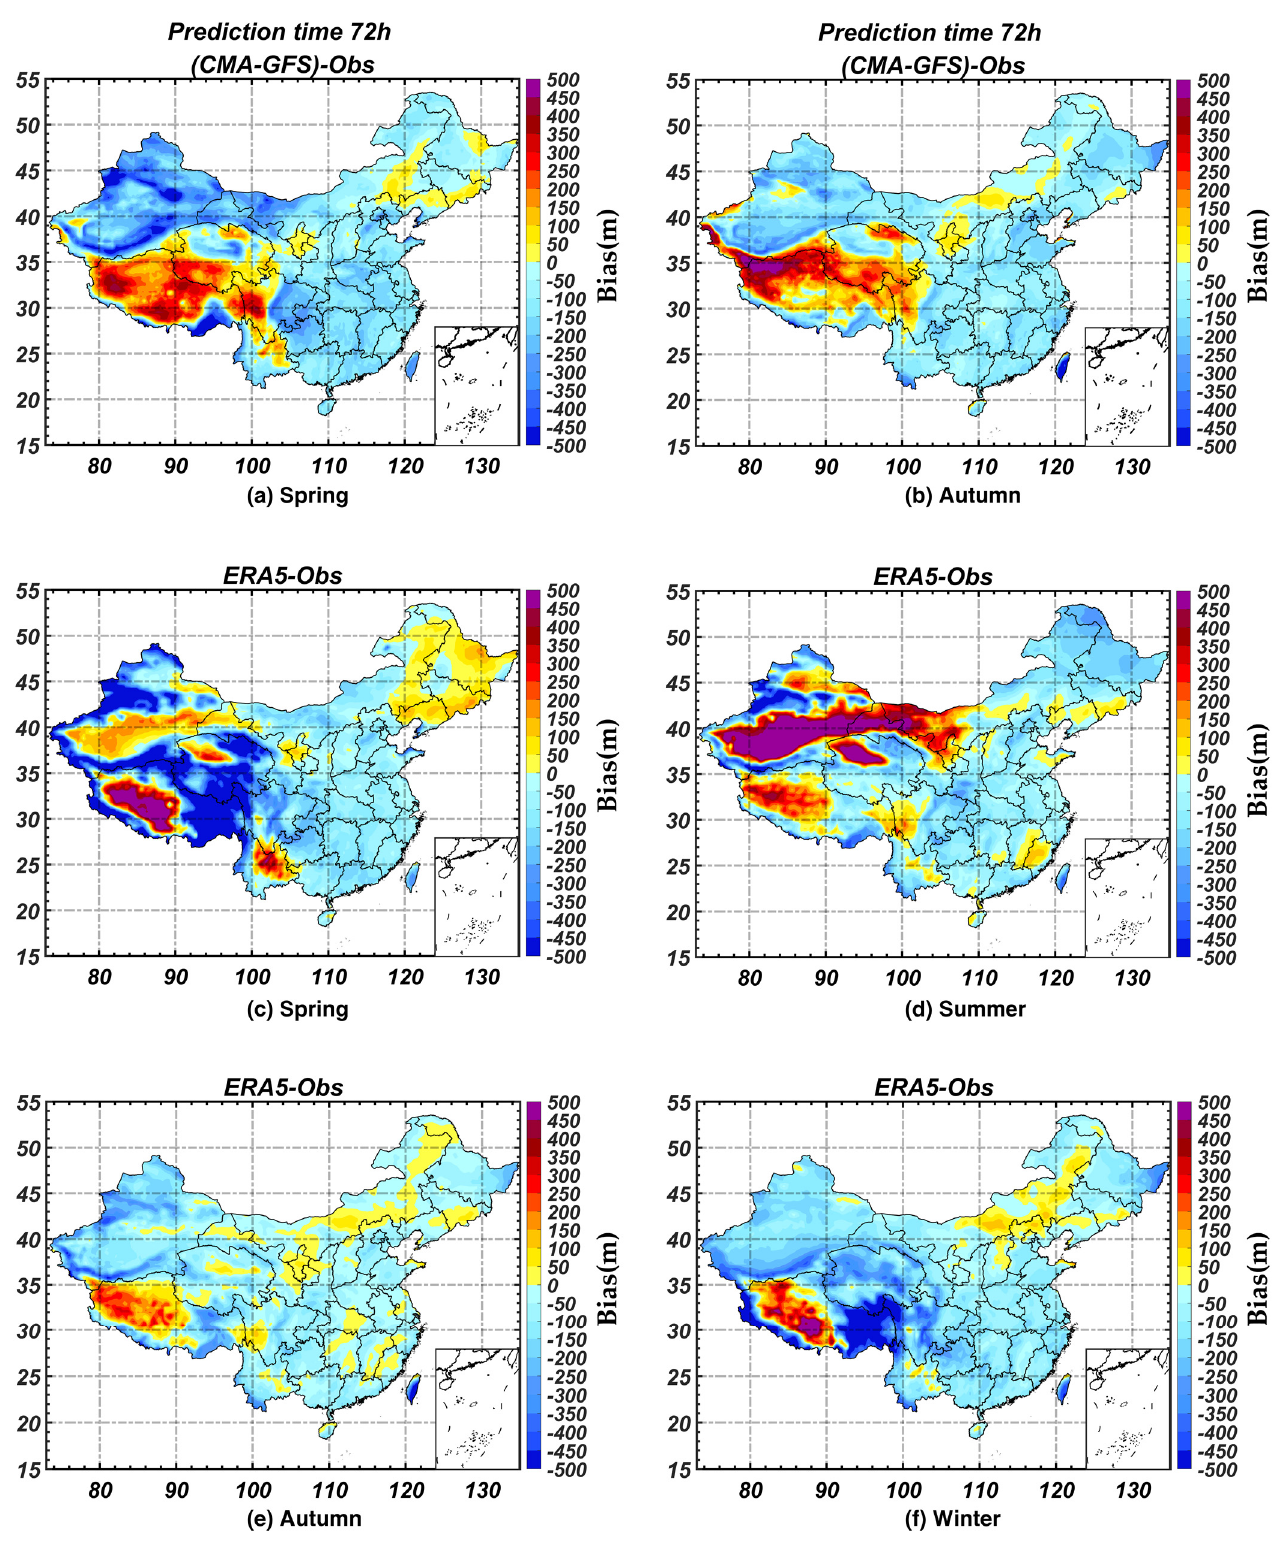
Figure 5. ( a , b ) The 72 h bias in the forecasts of the CMA-GFS model compared with the observations in ( a ) spring and ( b ) autumn, and the bias of the ERA5 reanalysis dataset compared with the observations in ( c ) spring, ( d ) summer, ( e ) autumn, and ( f ) winter.